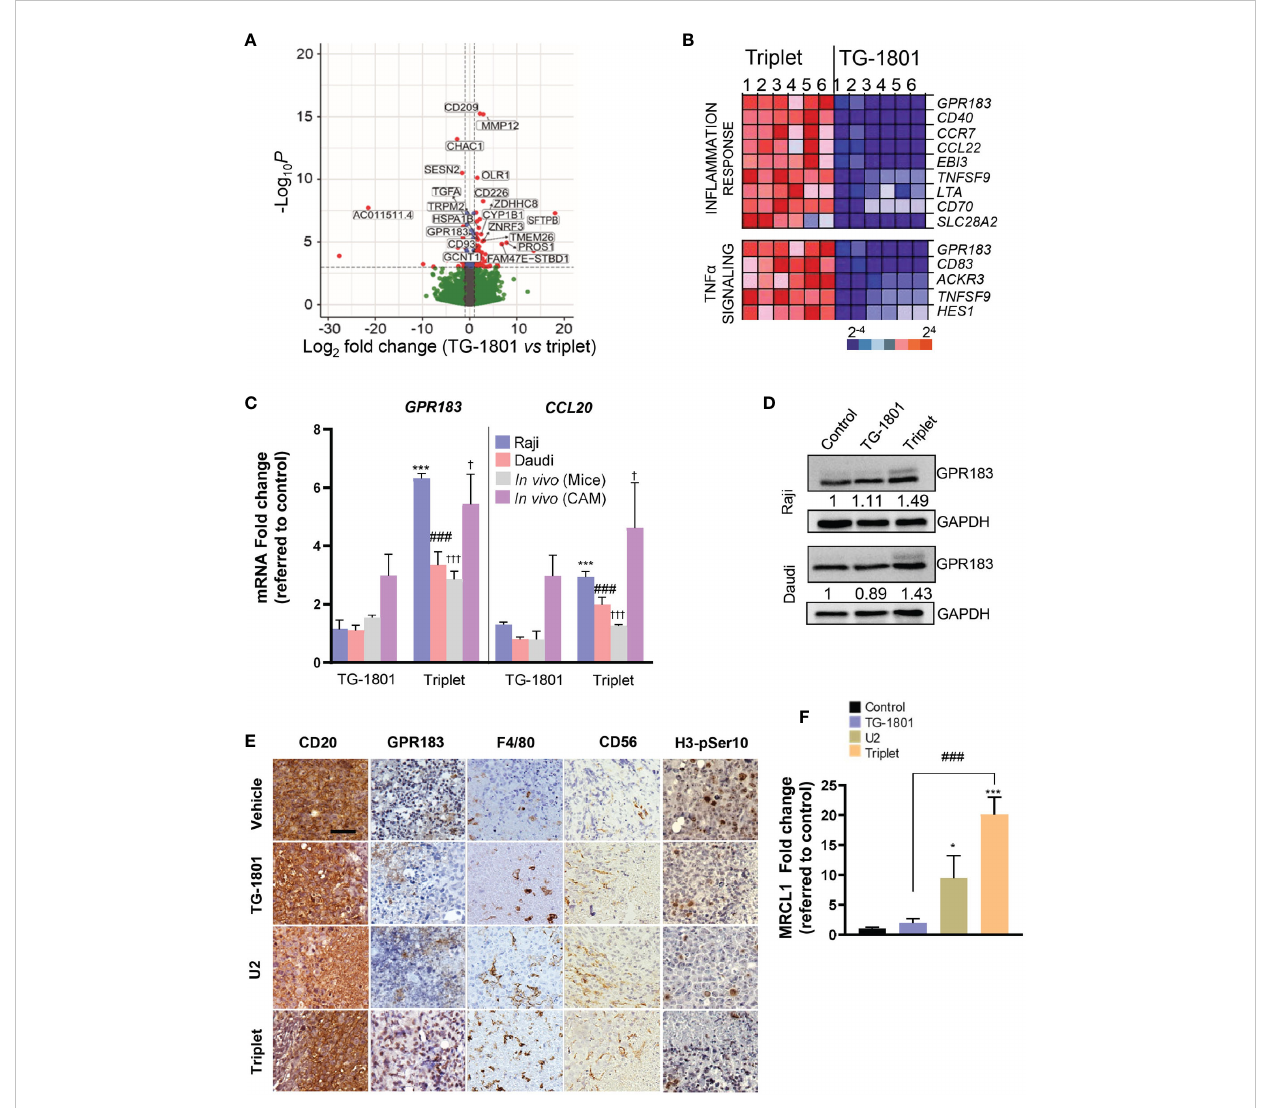
FIGURE 2 Upregulation of GPR183 is a hallmark of U2 and TG-1801 combinational effect in vitro and in vivo . (A) Volcano plot showing the most relevant signi fi cantly differentially expressed genes between triplet and TG-1801 treatments in n=6 BL samples (two cell lines, two primary samples and two representative Raji xenografts specimens). Genes undergoing a similar modulation in all the in vitro and in vivo models (n=20) have been labelled. (B) GSEA-mediated identi fi cation of the main enriched gene sets in the triplet-treated samples compared to the samples treated with TG-1801. Samples were sorted from left to right: 1-Raji, 2-Daudi, 3-4- BL primary samples and 5-6- CD20+ cells sorted from 2 representative Raji xenograft specimens. (C) qPCR determination of GPR183 and CCL20 transcript levels in Raji and Daudi cell lines exposed to TG-1801 or to the triplet therapy as previously, and in the two Raji in vivo (mouse and CAM) models dosed with the different agents. Values are referred to untreated Raji cultures. (D) Immunoblot detection and densitometric quanti fi cation of GPR183 protein levels (SantaCruz, #sc-514342) in BL cell lines exposed to TG-1801 +/- U2 dual asset, using GAPDH as a loading control. Values are normalized to control untreated cells. For each cell line, shown is a representative experiments out of three. (E) Immunohistochemistry (IHC) labelling of CD20 (Clone L26, Sigma-Aldrich), GPR183 (Clone G-12, Santa Cruz), F4/80 (Clone SP115, Abcam), Histone H3-pSer10 (Clone E173, Abcam) and CD56/NCAM-1 (Clone EPR1827, Abcam) in tissue sections from tumour specimens (shown are pictures from 1 out of 3 representative specimens) Scale bar: 50 µm. (F) MRCL1 transcript levels in the Raji-derived CAM model. Data are presented in fold-change related to the control (N=8-10) according to the different treatment regimens. * p <0.05, *** p <0.001, ### p <0.001, and † p <0.05 and ††† p <0.001 when compared to control group in Raji ( in vitro ), Daudi ( in vitro ) and Raji ( in vivo ) models, respectively. ns, non-signi fi